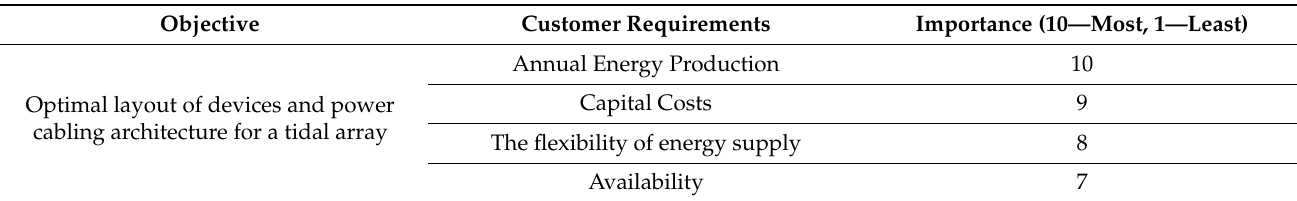
Table 1. Example of objectives, customer requirements, and ranking of their importance for a tidal developer improving their